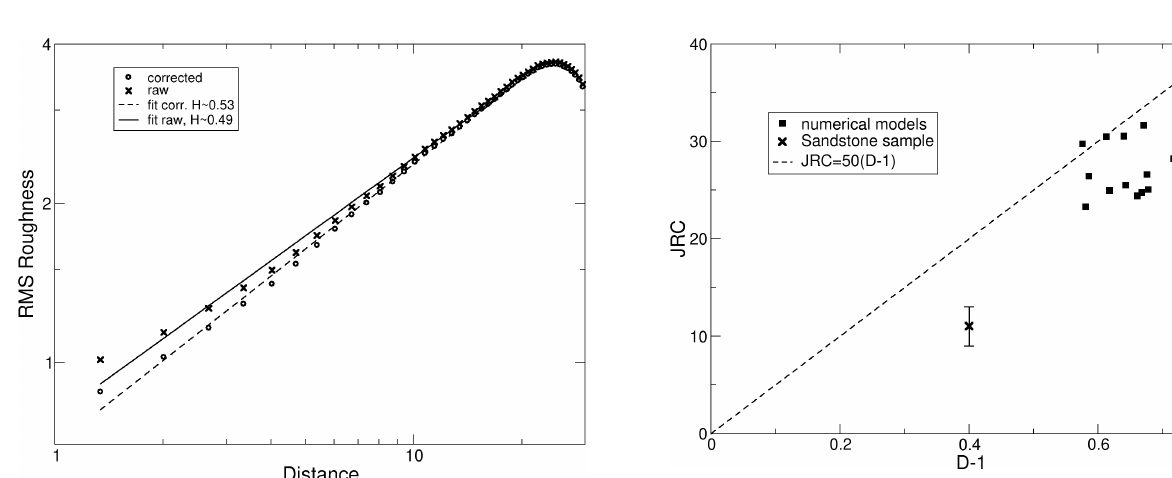
Figure 16. Comparison of the height–height correlation functions of a numerical fracture surface based on raw data (crosses) and corrected for the influence of the particle-scale roughness (circles). Lines are power-law fits used to calculate the Hurst exponents for raw (continuous line, H ≈ 0 . 49) and corrected data (dashed line H ≈ 0 . 53).